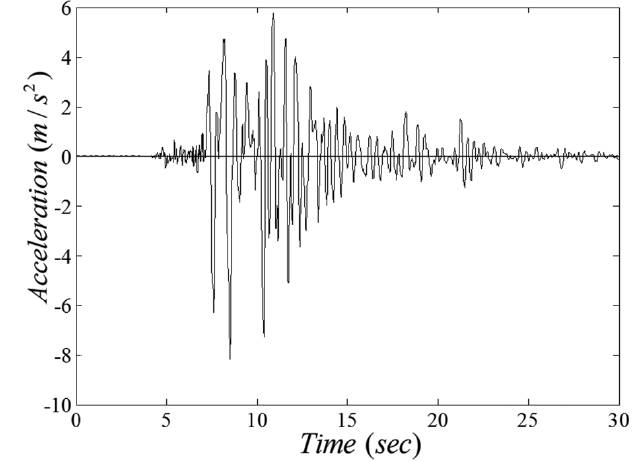
Fig. 11. Kobe seismic records within the fi rst 30s.